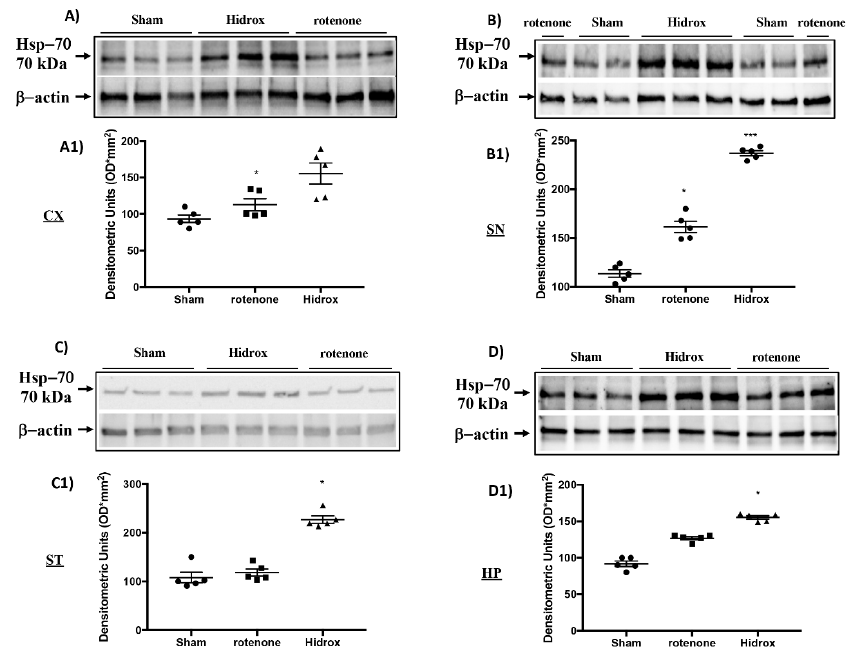
Figure 5. Effects of HD on the Hsp-70 protein after rotenone intoxication. Western blot analysis showed that the expression of Hsp-70 increased insignificantly in the rotenone group in CX ( A , A1 ), ST ( C , C1 ) and HP ( D , D1 ) regions, while there was a significant increase in the SN ( B , B1 ) area. HD treatment further significantly increased the expression of Hsp-70 ( A – D1 ). The data are expressed as the mean ± SEM from N = 5 mice/group. ( A1 ) * p < 0.05 vs. rotenone; ( B1 ) * p < 0.05 vs. rotenone; *** p < 0.001 vs. Sham; ( C1 ) * p < 0.05 vs. rotenone; ( D1 ) * p < 0.05 vs. rotenone. Antioxidants 2020 , 9 , x FOR PEER REVIEW